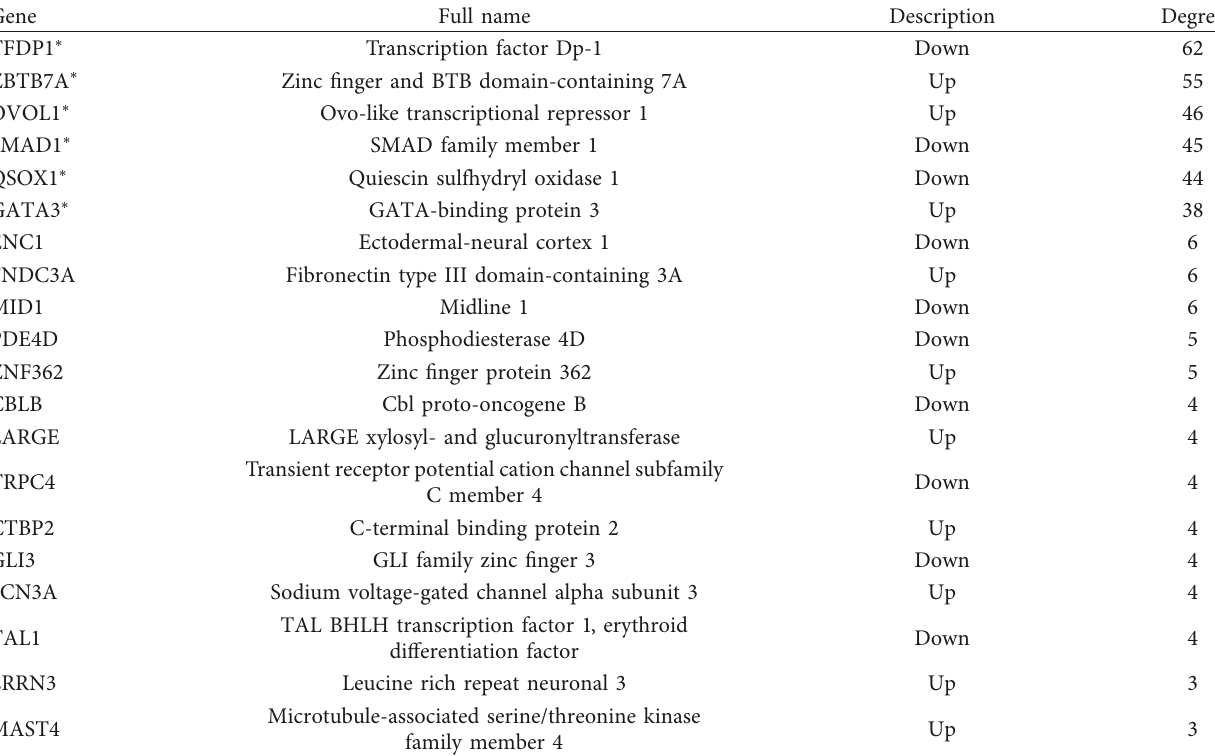
Table 3: List of top 20 nodes with higher degree in transcription factor-target regulatory